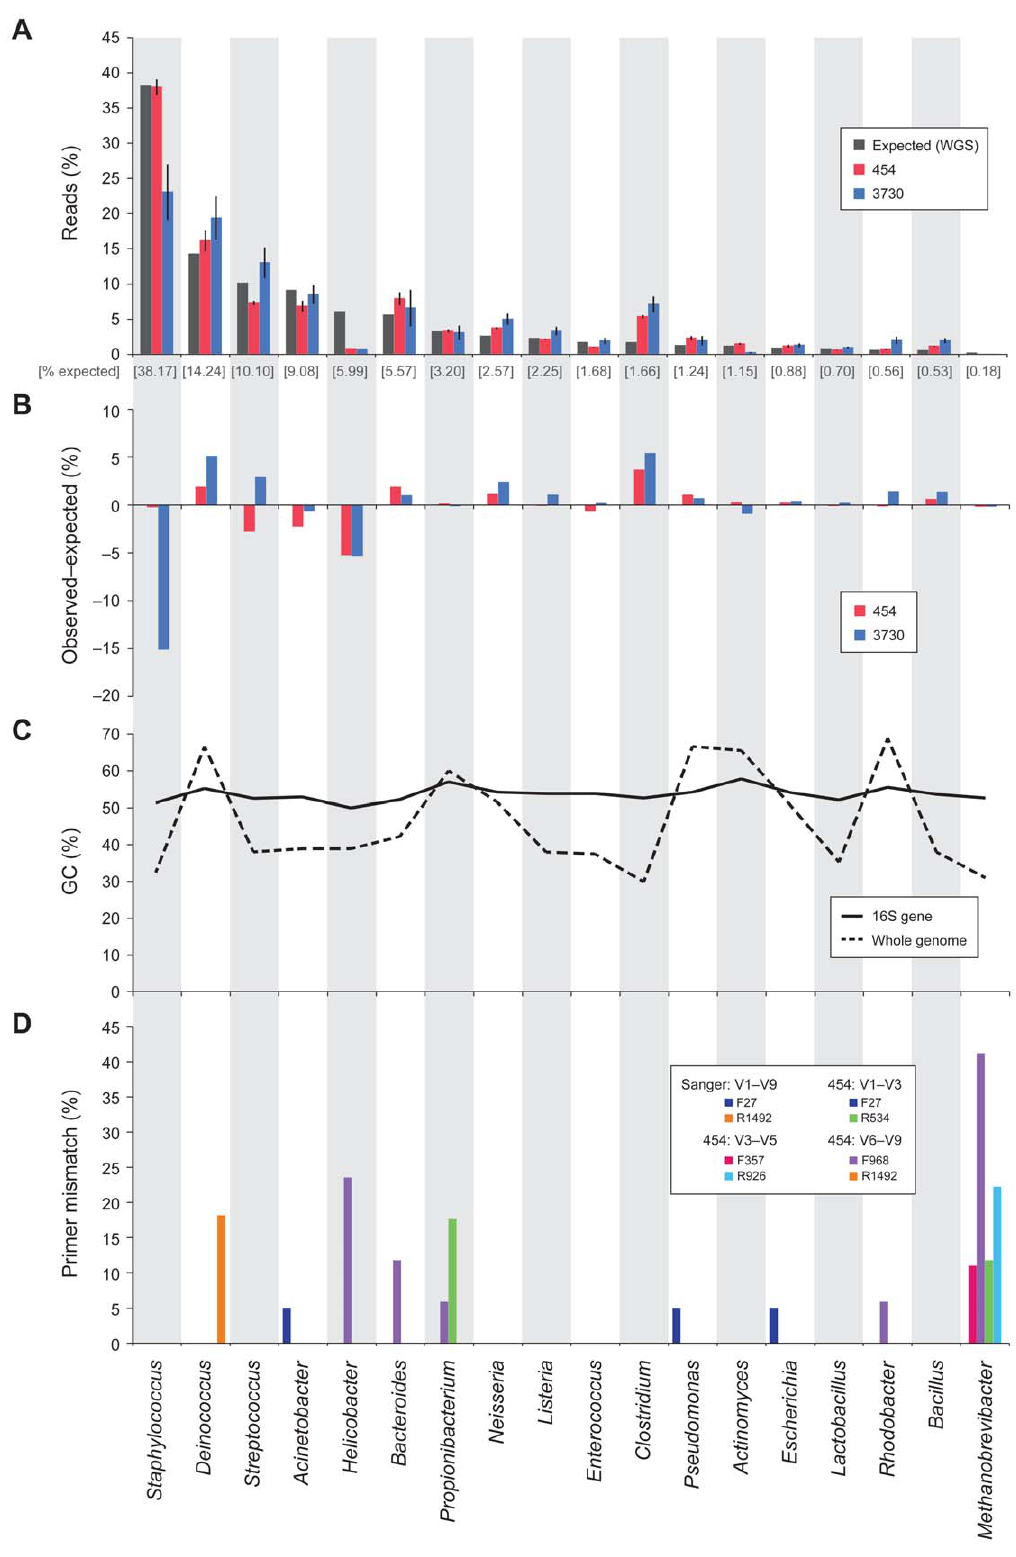
Figure 4. Deviation from expected in the 16S based Mock Community member representation can partially be explained by primer mismatch, not by %GC differences. The 20 bacterial organisms of the Mock Community are represented by corresponding genus (n=18) along the bottom of the figure, and across the four panels (DNA from Candida albicans was included in this mock community, but not shown here). (A) The distribution of reads over the 18 genera; The expected frequencies (grey) in the community determined by whole genome shotgun (WGS) sequencing and classified by mapping to reference genomes using BWA, and the observed frequencies determined by 454 reads (red) or 3730